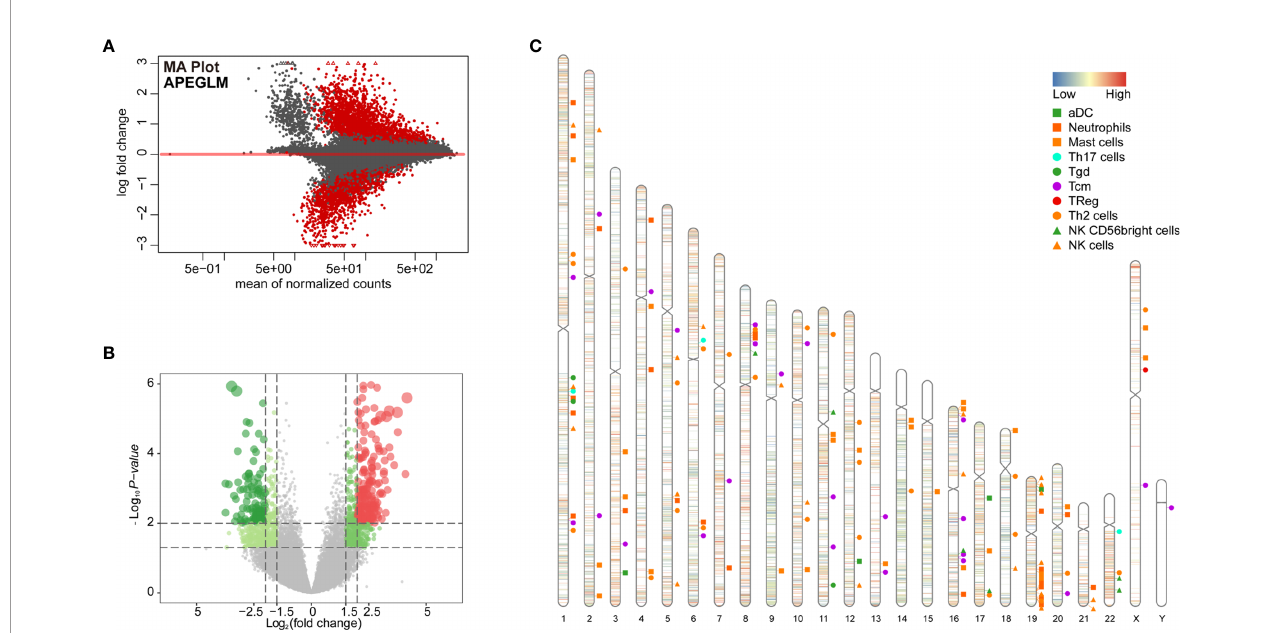
FIGURE 4 | Differential peak analysis of TCGA-KIRC ATAC-seq data based on two clusters. (A) MA distribution map of change folds of peaks; (B) 2,400 differential peaks ( Supplementary Table 6 ) when the corrected p-value <0.05, change folds greater than 2; (C) Distribution of differential peaks and prognosis-related immune cells on